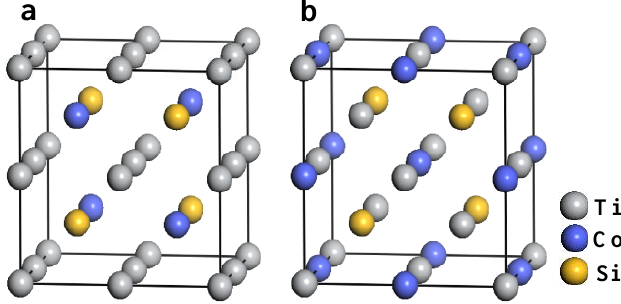
Figure 2. Crystal cell of Ti 2 CoSi with ( a ) regular cubic Heusler structure and ( b ) an inverse cubic Heusler structure.